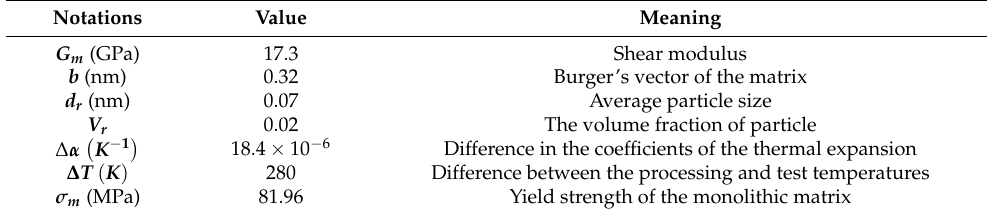
Table 3. The notations and values for yield strength